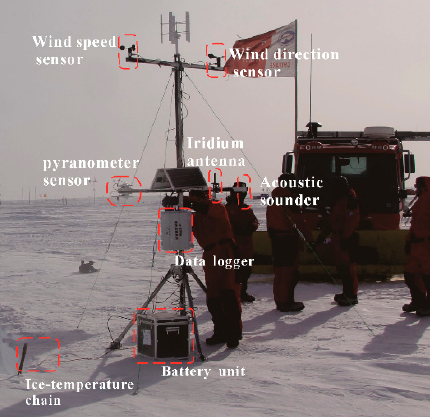
Figure 3. Meteorological observatory deployed in the Antarctic inland during the 2016 Chinese National Antarctic Research Expedition.